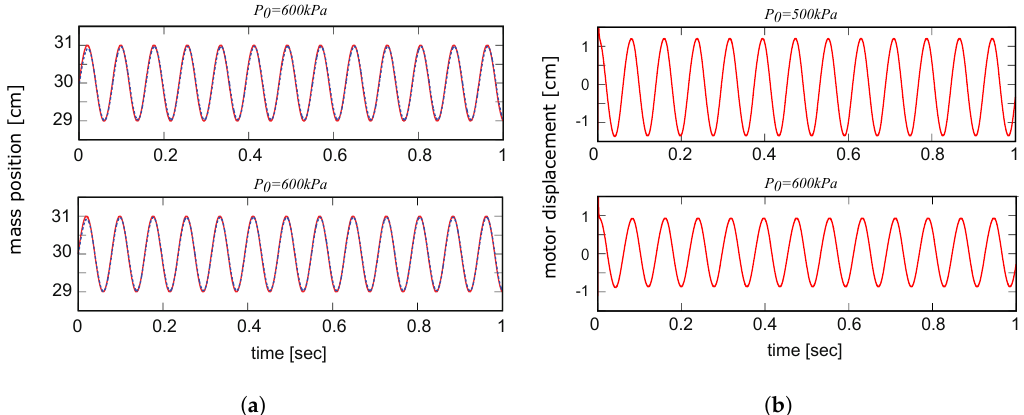
Figure 5. The mass and motor position. The no-load (initial) muscle pressure are 500 kPa and 600 kPa in top and bottom graphs, respectively. ( a ) The desired (red solid lines) and actual (blue dashed line) trajectory of mass position; and ( b ) the trajectory of motor position of the EPA.